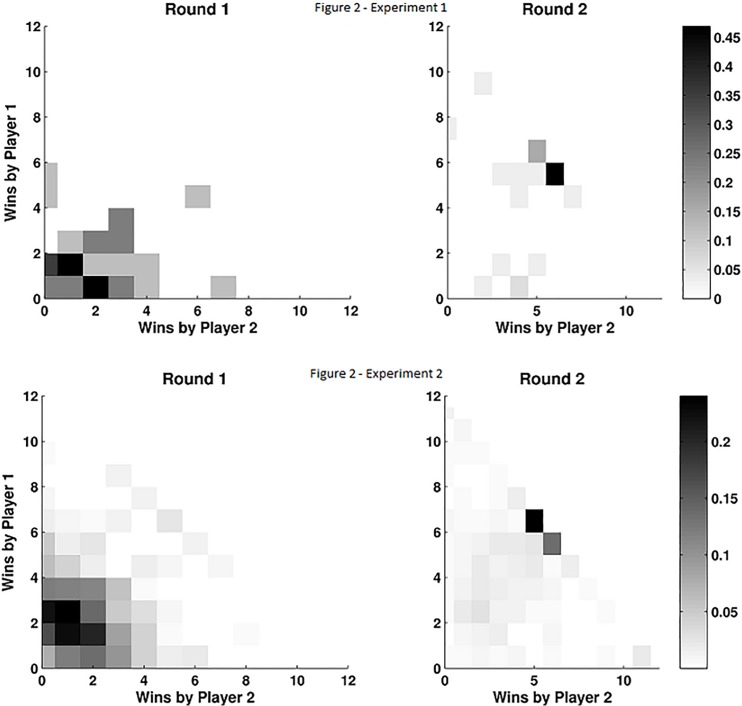
Dimensional histogram of the number of points scored by each player.In the first round (left panel) the distribution is clustered close to the origin showing that players rarely score more than 2 points. In the second round (right panel) the majority of dyads show that both players win 5 or 6 points (11 was the maximal amount of points they could accumulate).